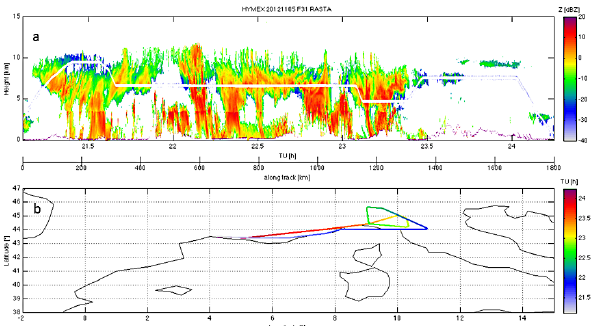
Figure 20. Falcon 20 flight on 4 November 2012 (21:00UTC to 23:50UTC): (a) reflectivity; (b) flight track. Courtesy of Julien De- lanoe (LATMOS/IPSL/UVSQ, France).